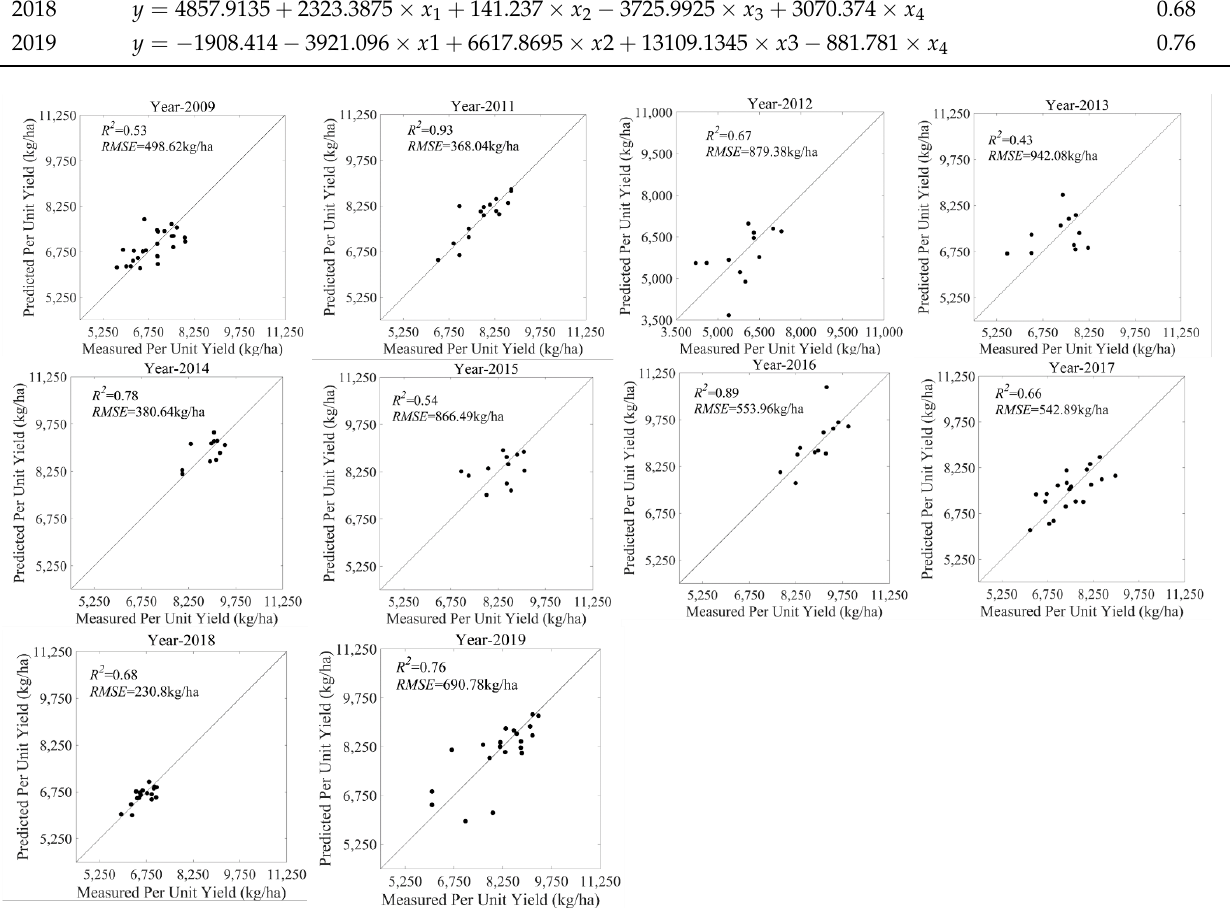
Figure 5. The relationship between the measured value and the predicted value of winter wheat yield.